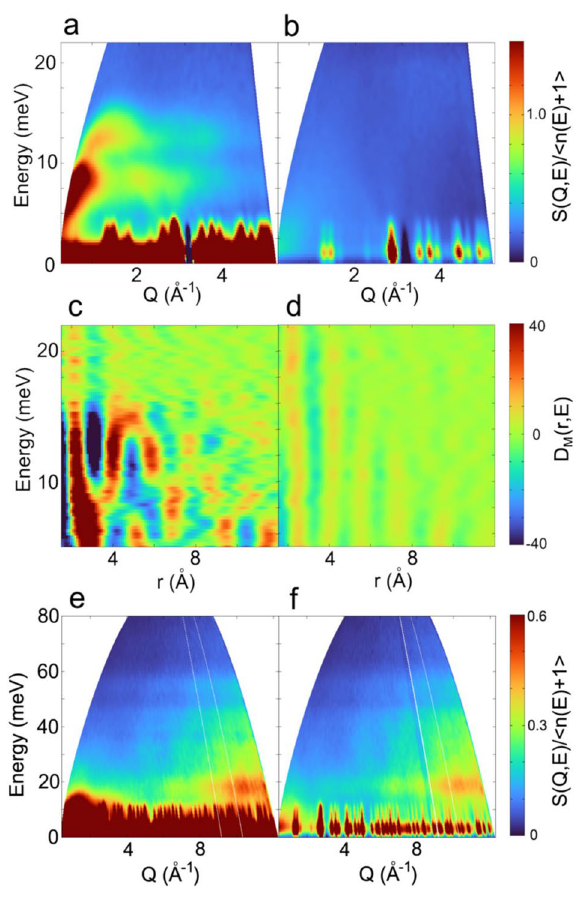
Figure 3. (a) Bose-factor corrected dynamic structure factor S ( Q, E )/< n ( E ) + 1 > of FeTiO 3 measured with E i = 46 meV at T = 8 K. ( b) at T = 200 K. ( c) Dynamic magnetic pair-density function D M ( r, E ) of FeTiO 3 at T = 8 K. ( d) at T = 200 K. ( e) Bose-factor corrected dynamic structure factor S ( Q, E )/< n ( E ) + 1 > of FeTiO 3 measured with E i = 95 meV at T = 8 K. ( f) at T = 200 K. Low-energy spiky peaks in S ( Q, E )/< n ( E ) + 1 > are originated from strong Bragg peaks, which extend with the